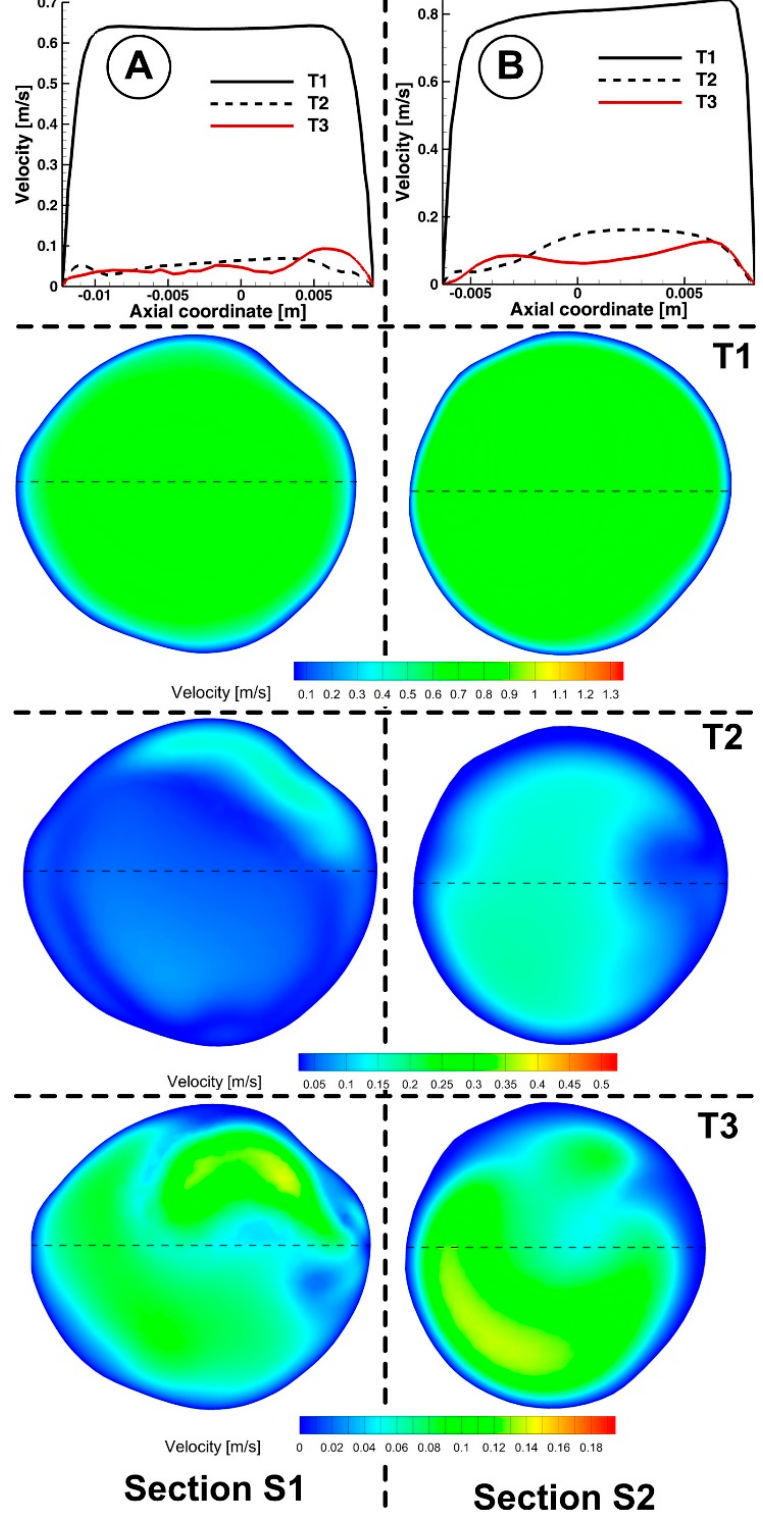
Figure 15. Velocity magnitude contour in different time steps in sections S1 ( A ) and S2 ( B ) (see Figure 13). The velocity evolution was plotted approximately along the section diameter (dashed line in each section).